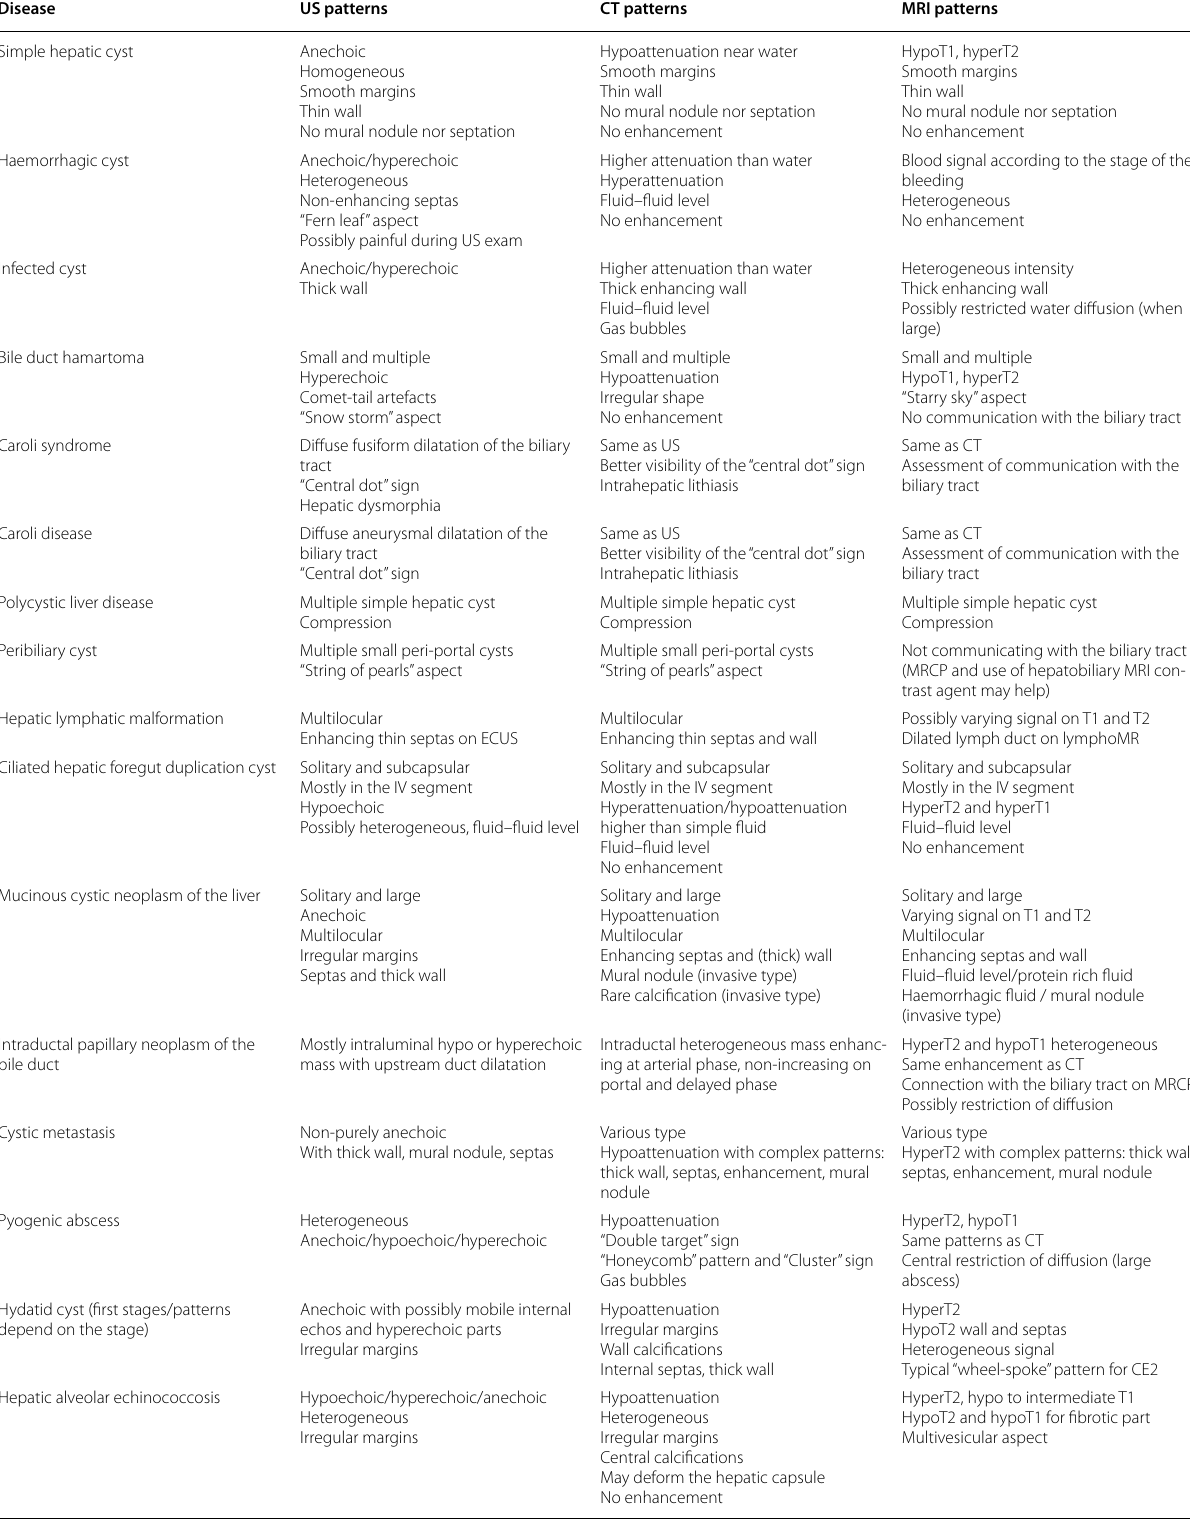
Table 2 Summary of the imaging patterns for each cystic disease